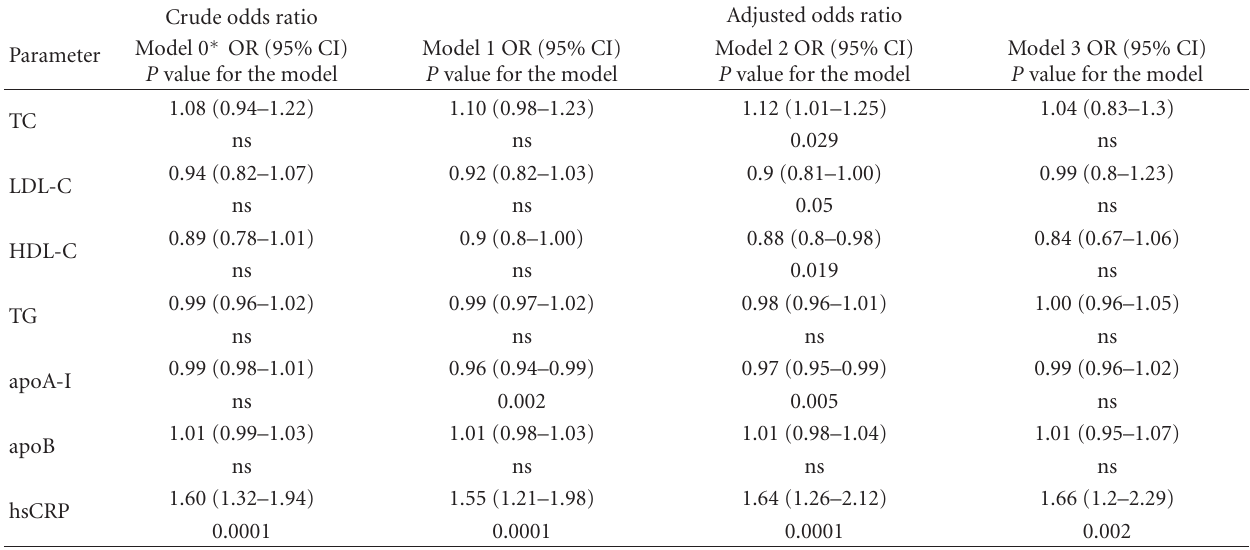
Table 4: The risk of the acute coronary syndrome for primary